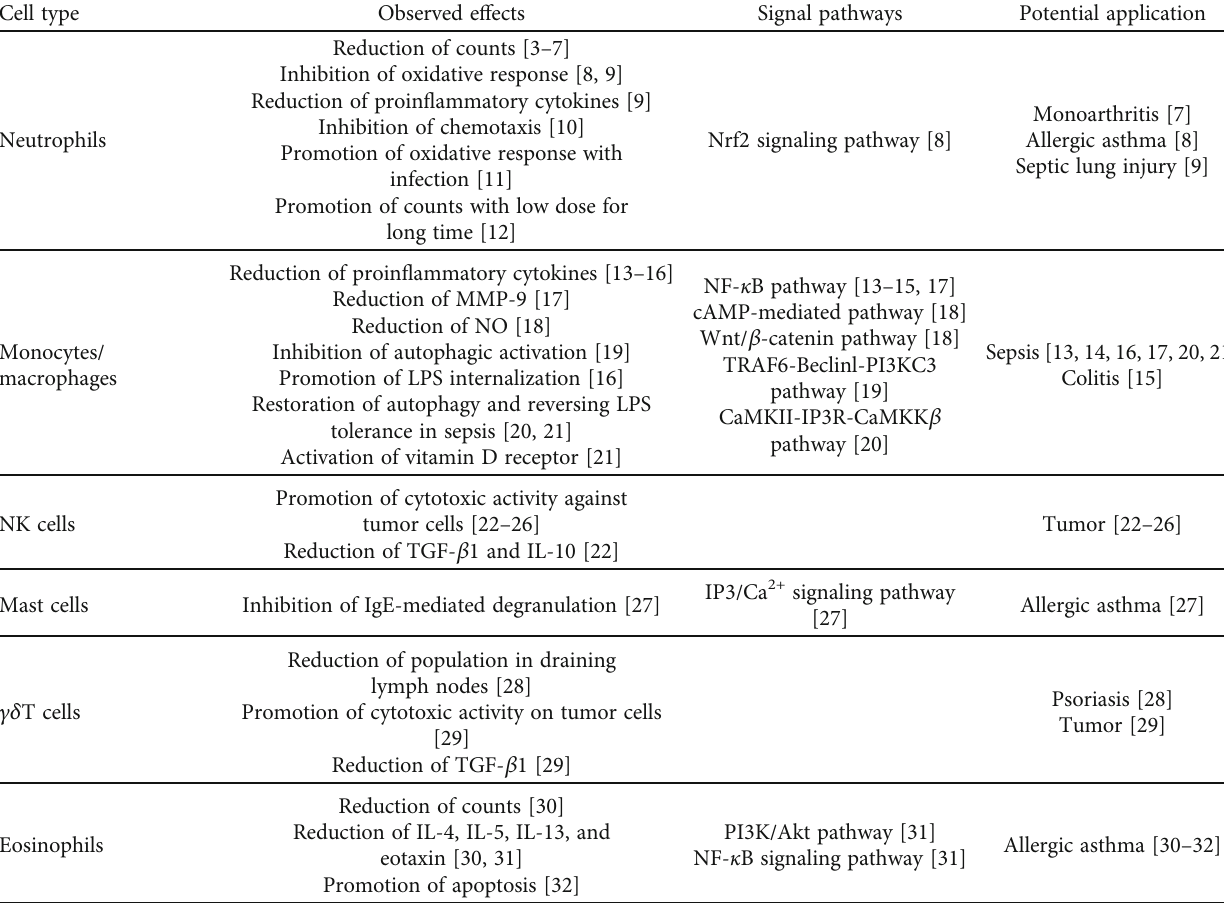
Table 1: E ff ects of artesunate on some innate immune cells and potential application.